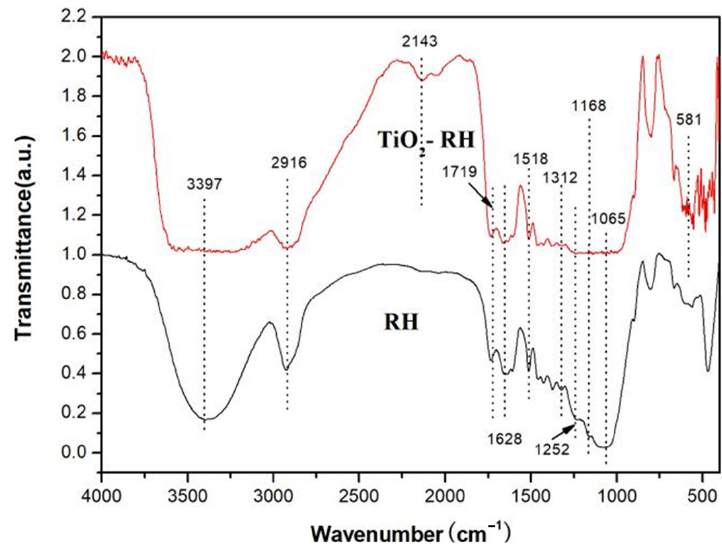
Figure 3. FTIR spectra of RH and TiO 2 -RH.